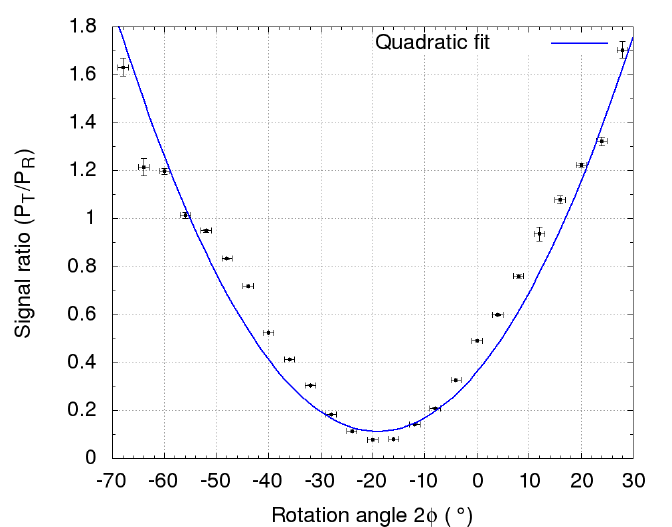
Figure 5. The signal ratio between P (cid:107) and P ⊥ with the corresponding rotation angle of the HWP. The minimum of the quadratic fit to the data points was used to determine the offset angle of the polarization plane to be − 18 ± 1 ◦ , where the HWP was rotated for φ = − 9 ± 1 ◦ with respect to the horizontal polarization plane of the